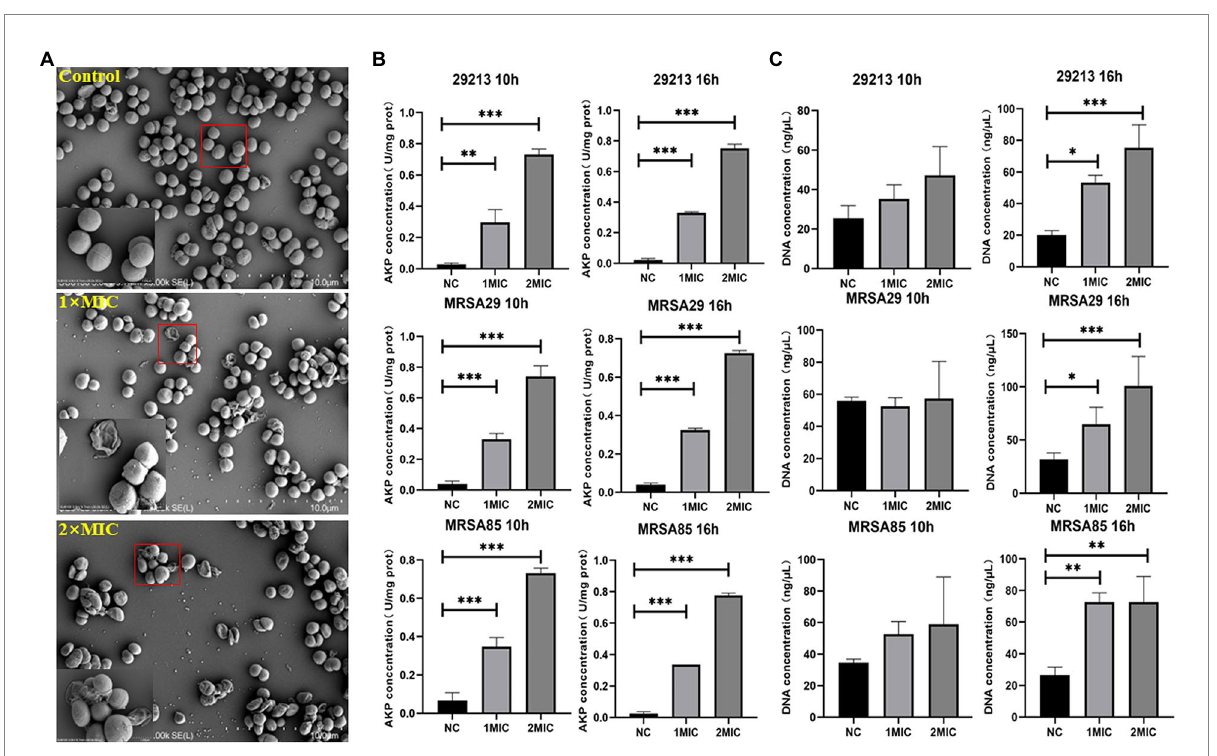
FIGURE 3 Antibacterial effects of organic acid of Portulaca oleracea L. (OAPO) on the morphology and integrity of the cell wall and membrane of Staphylococcus. aureus . (A) The morphology changes of S. aureus untreated (Control) or treated with 1× and 2× minimum inhibitory concentration (MIC) of OAPO by scanning electron microscopy (SEM). A red square indicates that this part was magnified by 10 times. (B) Effect of OAPO on the cell wall of S. aureus (29,213, MRSA29, and MRSA85 strains) at 10 and 16 h post-treatment with one-fold and two-fold MIC of OAPO (or after no treatment). The alkaline phosphatase (AKP) concentration of the bacterial culture solution was determined. (C) Effect of OAPO on the integrity of the cell membrane of S. aureus (29,213, MRSA29, and MRSA85 strains) at 10 and 16 h post-treatment with one-fold and two-fold MIC of OAPO (or after no treatment). The DNA concentration of the bacterial culture solution was determined. *indicates p < 0.05, **indicates p < 0.01, ***indicates p < 0.001 when compared with the negative control group (NC, untreated with